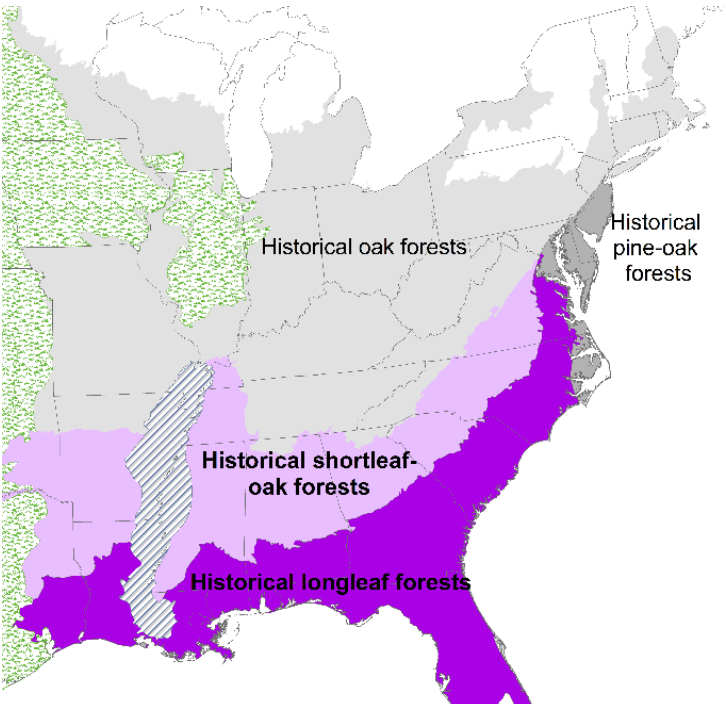
Figure 1. Generalized depiction of primary historical ecosystems in the eastern United States (modified from [24]). Historical surface fire-dependent open longleaf pine or shortleaf pine-oak forests dominated the southern and northern ecological provinces (shaded light and dark purple) of the southeastern United States. Open oak forests (most of the central eastern region shaded gray, although closed forests of shade-tolerant species co-occurred in this region) and grasslands (the central United States, shaded green) also were maintained by frequent surface fires, while pine-oak forests (dark gray) probably relied on a mixed severity fire and wind regime, and boreal forests (portions of the white, non-shaded northernmost region) auto-replaced after high severity fire every 50 to 150 years. In other parts of the northernmost region, fires occurred >1000 years, resulting in disturbance-independent closed forests. Floodplain forests in the Lower Mississippi Alluvial Valley (striped) experienced fire that spread from adjacent uplands but were more influenced by flooding disturb- ance.